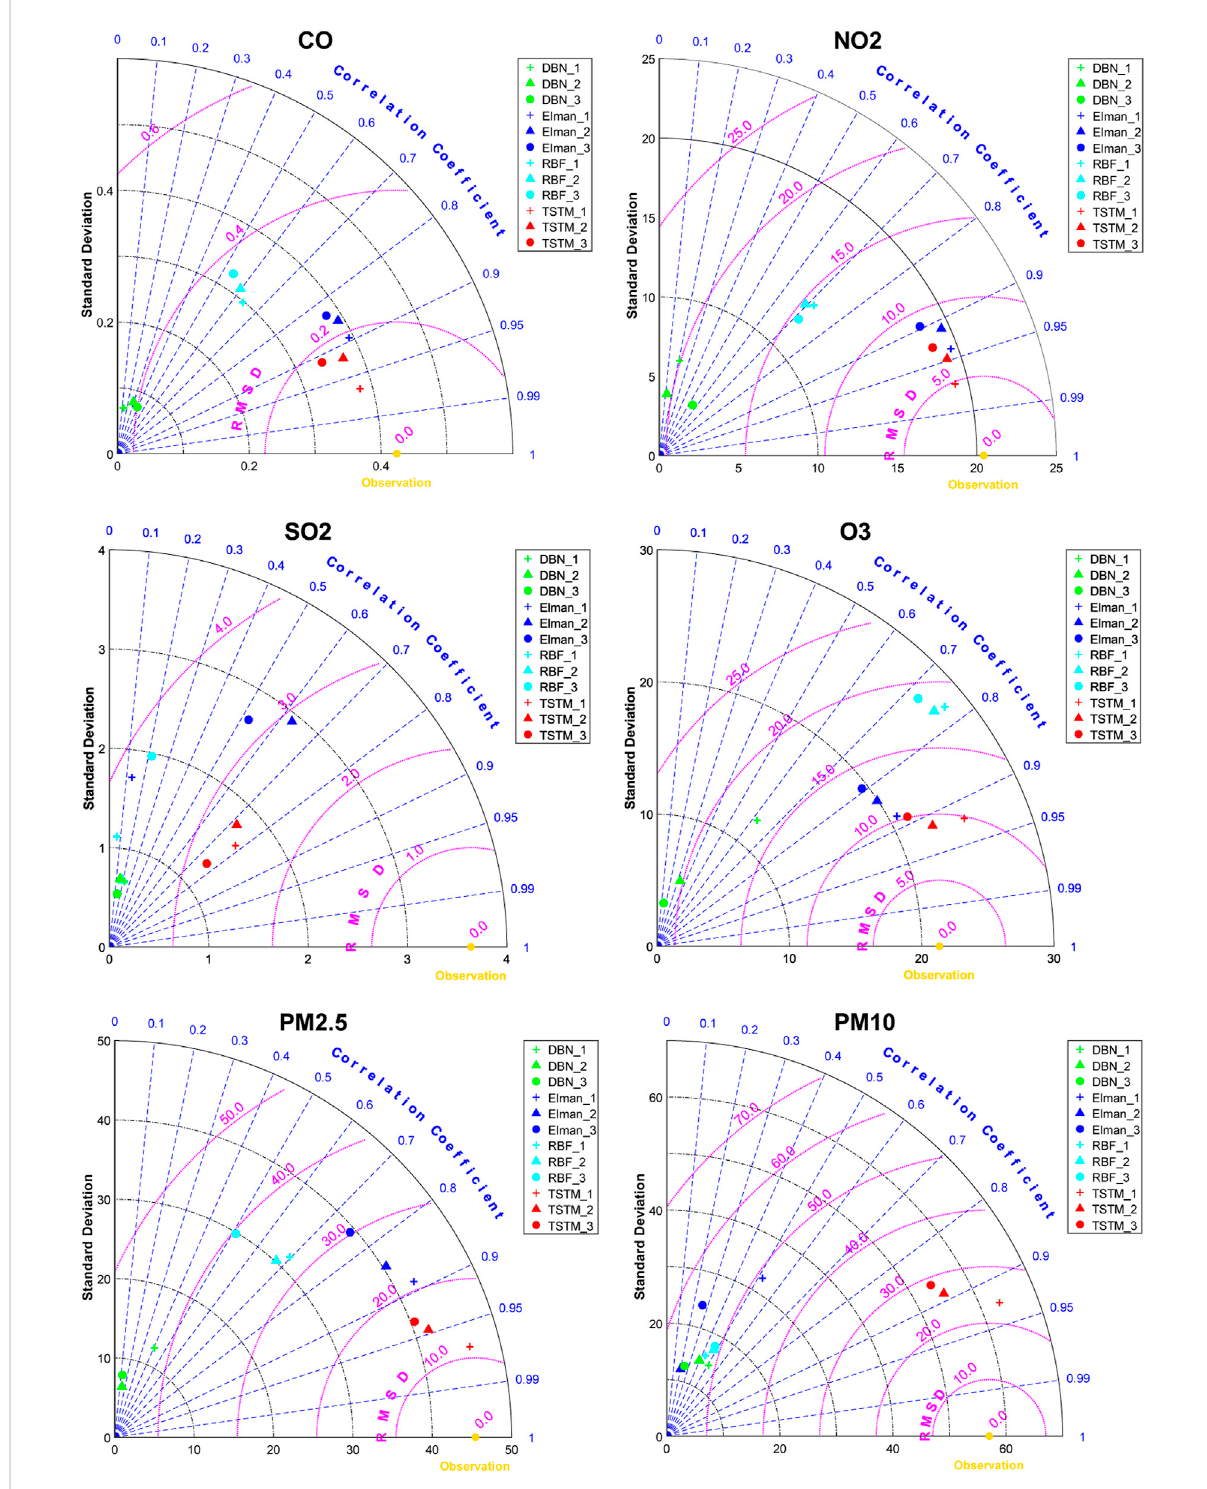
FIGURE 12 The Taylor diagram of pollutant concentration prediction in Beijing (Test